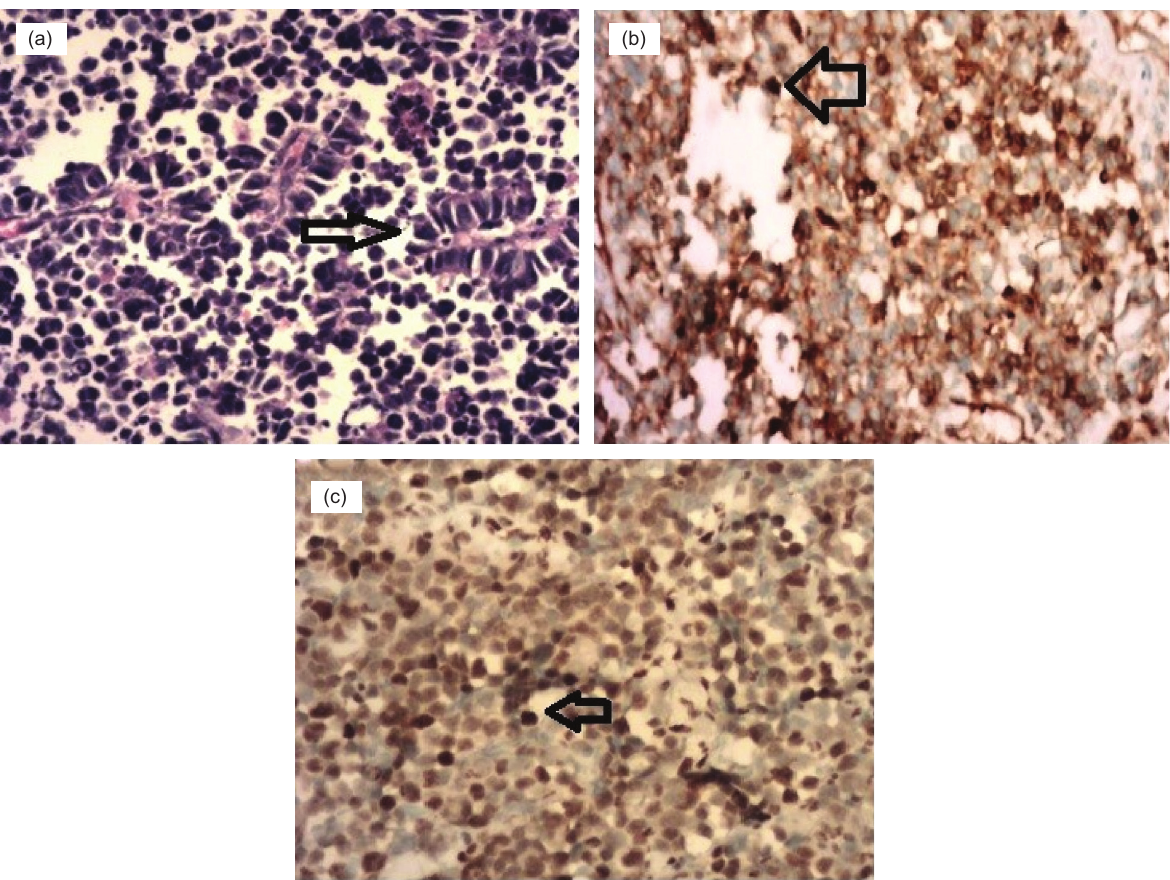
Figure 3: Histopathology and immunohistochemistry of case 4. (a) Showing (Hematoxylin–Eosin staining) small uniform round cells with a hyperchromatic nucleus and mild to moderate pale staining cytoplasm and pseudo-rosettes (20×). (b) Small round cells CD-99 IHC positive (20×). (c) Small round cells, FLI-1 positive